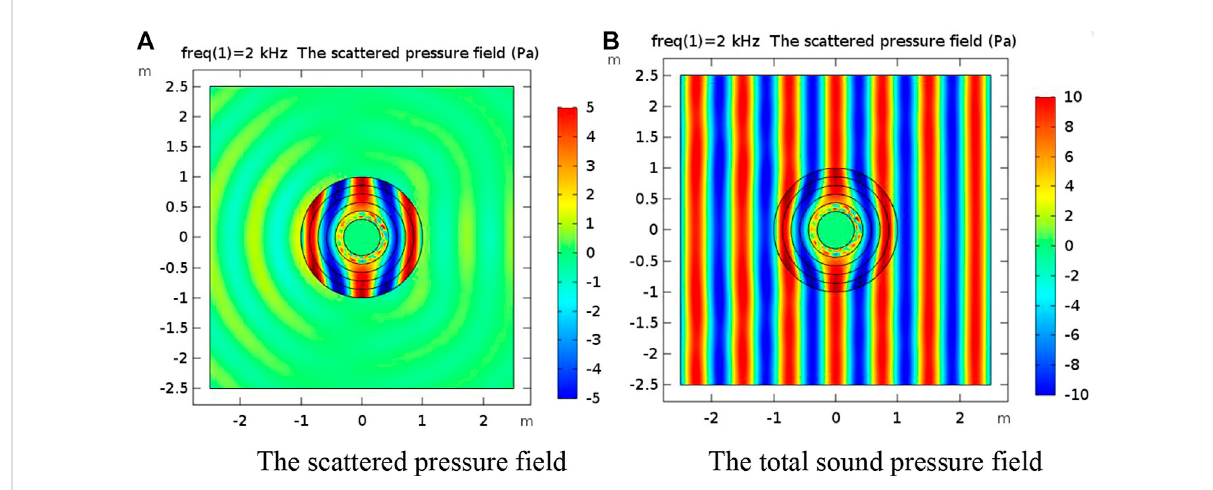
FIGURE 9 (A) The scattered pressure fi eld before cloak structure optimization. (B) The total sound pressure fi eld before cloak structure optimization.